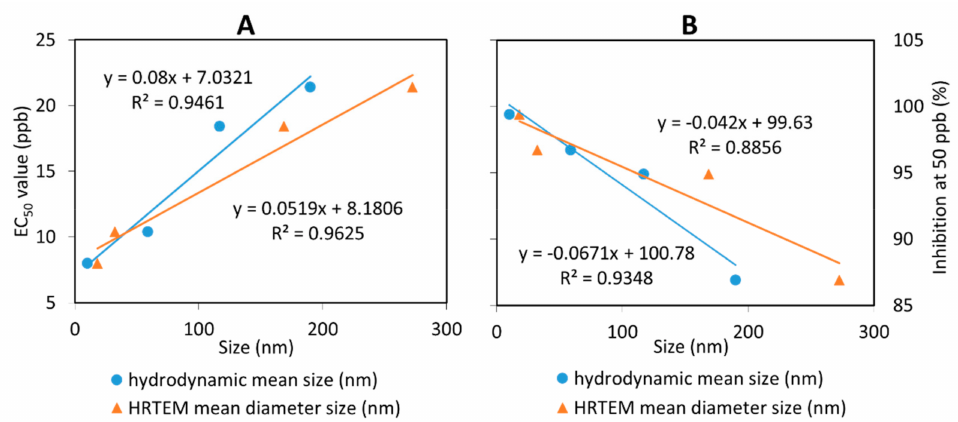
Figure 10. The relationship between the hydrodynamic mean particle size distribution and HRTEM mean particle size distribution of the synthesized chitosan–hexaconazole nanoparticles to ( A ) their percentage inhibition at 50 ppb and ( B ) the calculated EC 50 (ppb) value on G. boninense